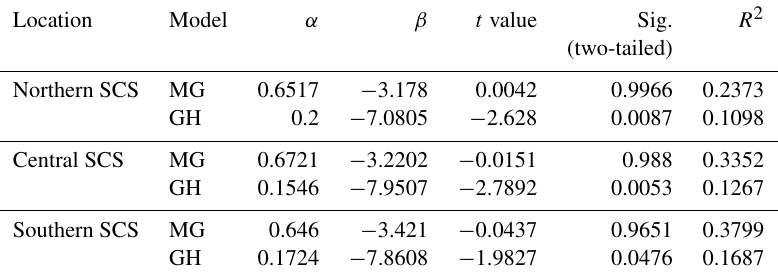
Table 2. Results of the linear regression and t -test.